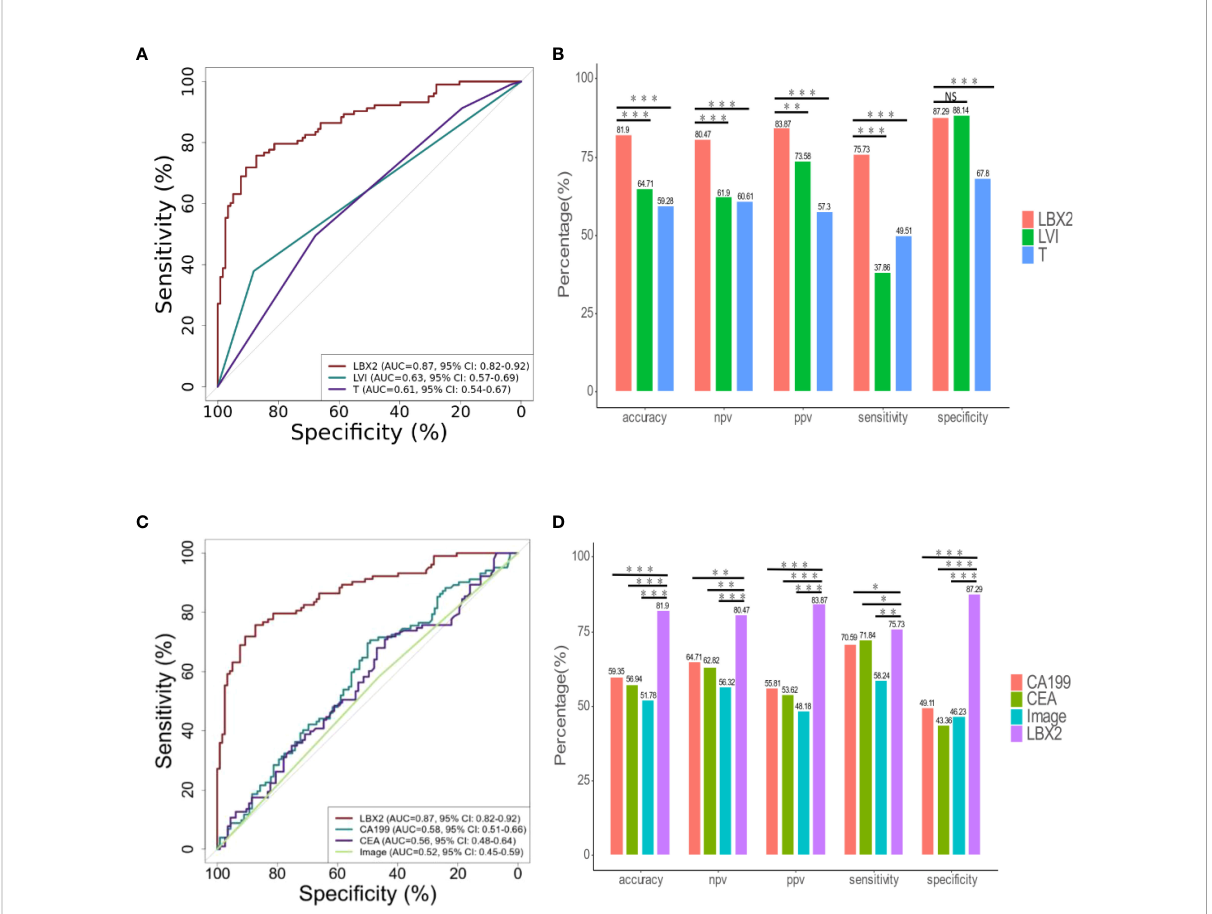
FIGURE 5 The comparison of LBX2 and traditional indicators (clinical pathology, CA199, CEA, and image) to detect LNM of CRC. (A) ROC curve of three indicators ( LBX2 , LVI, and T). The effectiveness of three indicators was evaluated by comparing AUC values. (B) The accuracy, NPV, PPV, sensitivity and speci fi city of these three indicators were compared respectively. (C) ROC curve of four indicators ( LBX2 , CA199, CEA and image). The effectiveness of four indicators was evaluated by comparing AUC values. (D) The accuracy, NPV, PPV, sensitivity and speci fi city of these four indicators were compared respectively. *p < 0.05, **p < 0.01 and ***p < 0.001. NS: not statistically signi fi